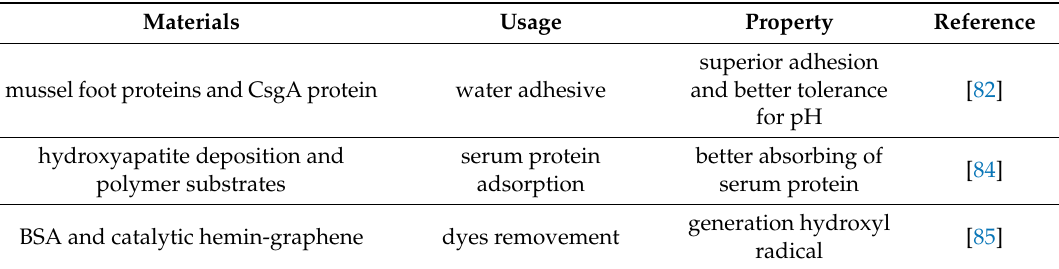
Table 3. Adhesive bio-inspired materials application and